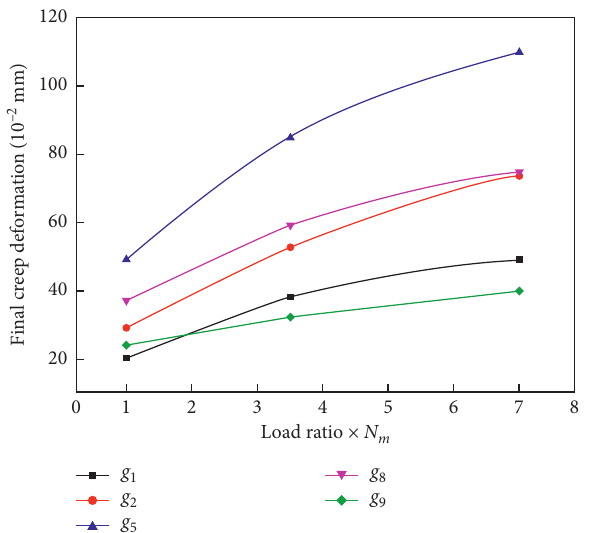
Figure 13: Final creep deformation of points g